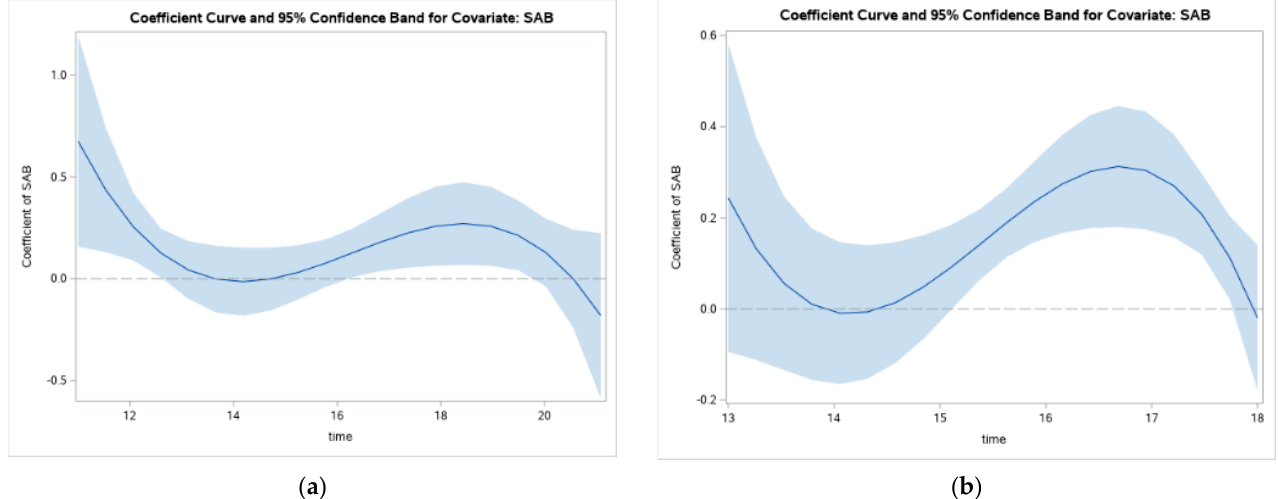
Figure 5. Changes in relations between SAB and GHQ scores through adolescence for Catholics ( a ) and Protestants ( b ).